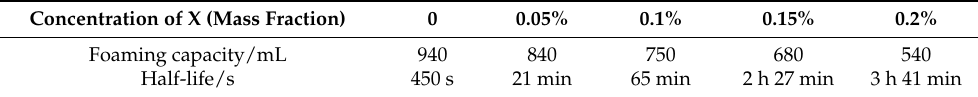
Table 3. X Foam volume and half-life at different concentrations.